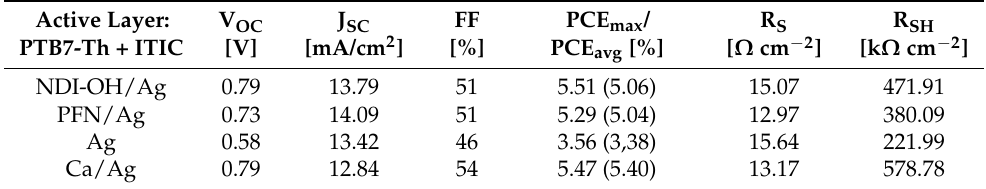
Table 2. Figures of merit for non-fullerene-based PSCs. Active layer PTB7-Th + ITIC.